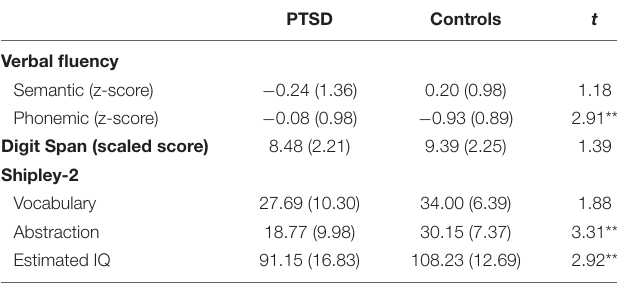
TABLE 2 | Assessment of cognitive